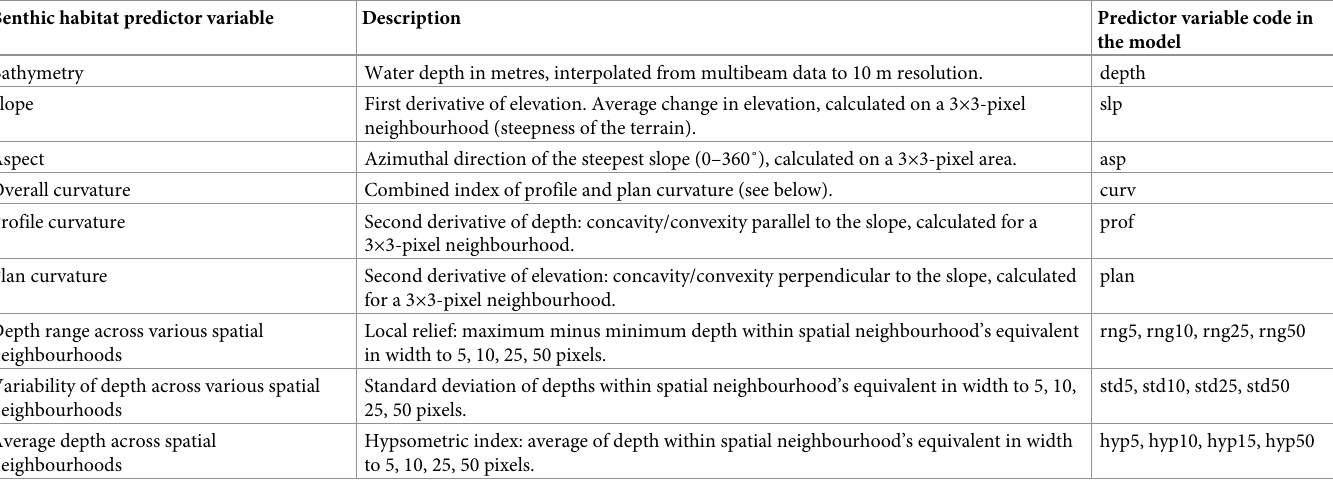
Two sets of predictors were derived: one set for the AC125 spatial model using mosaiced 10 m pixel bathymetry rasters collected in this study, and one set using 250 m pixel coarse-scale